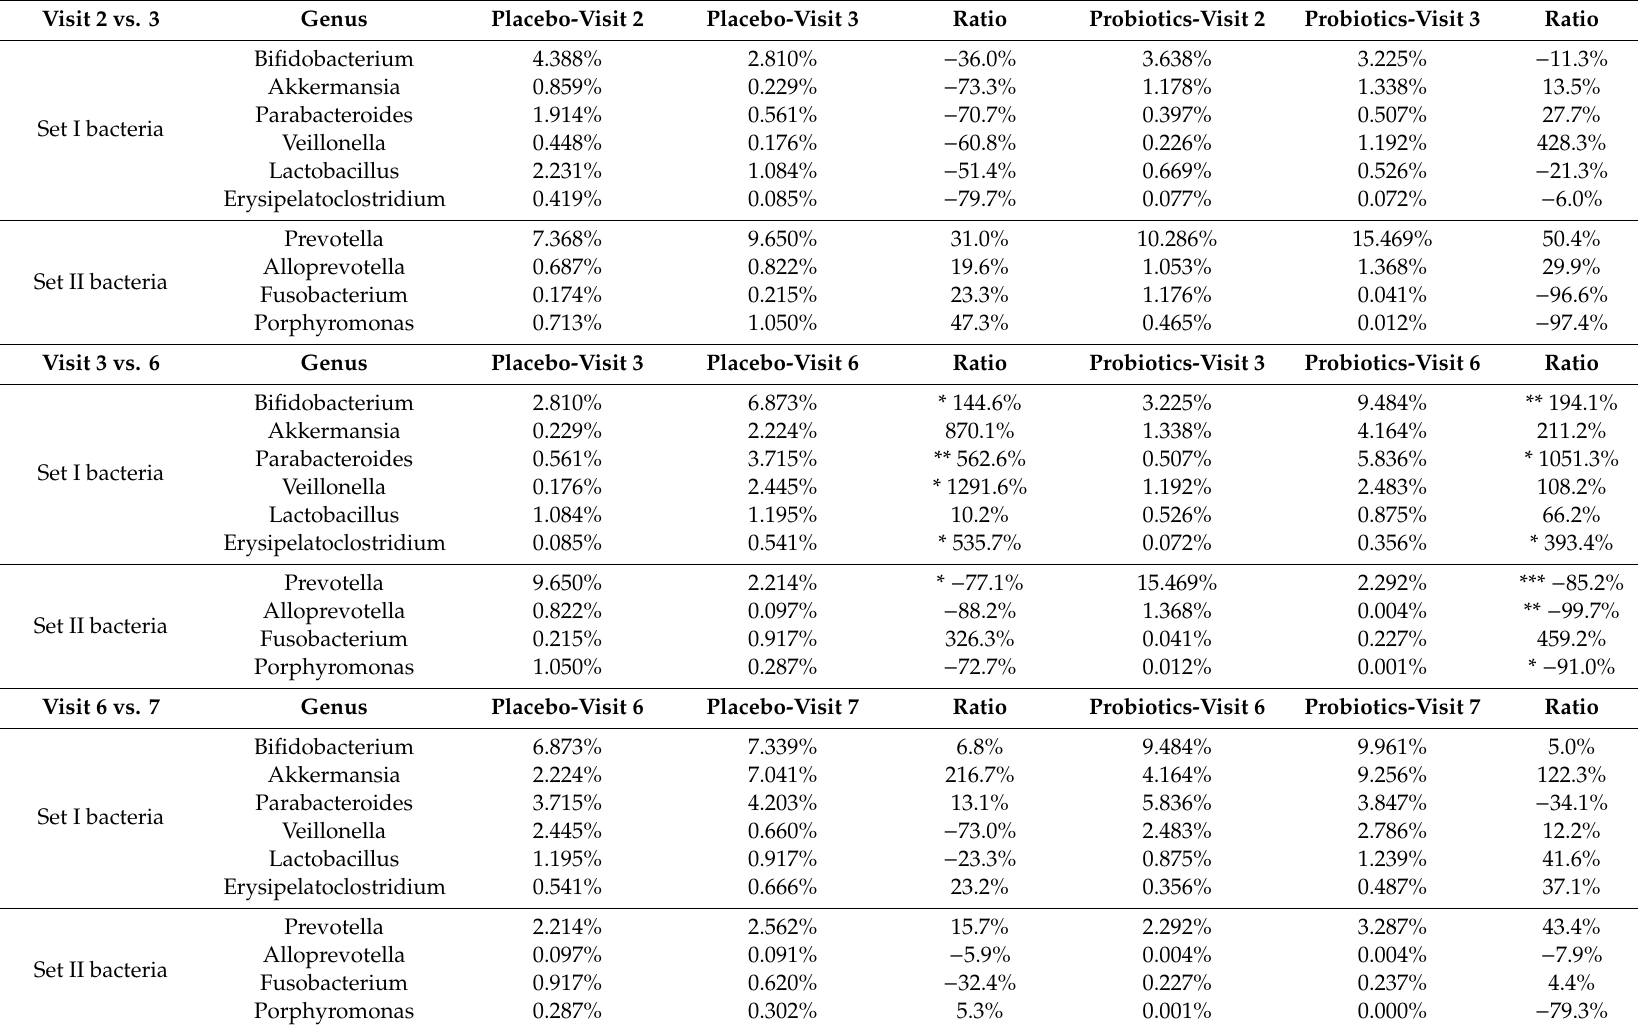
Table 2. Compositional change in the bacterial set between sampling time